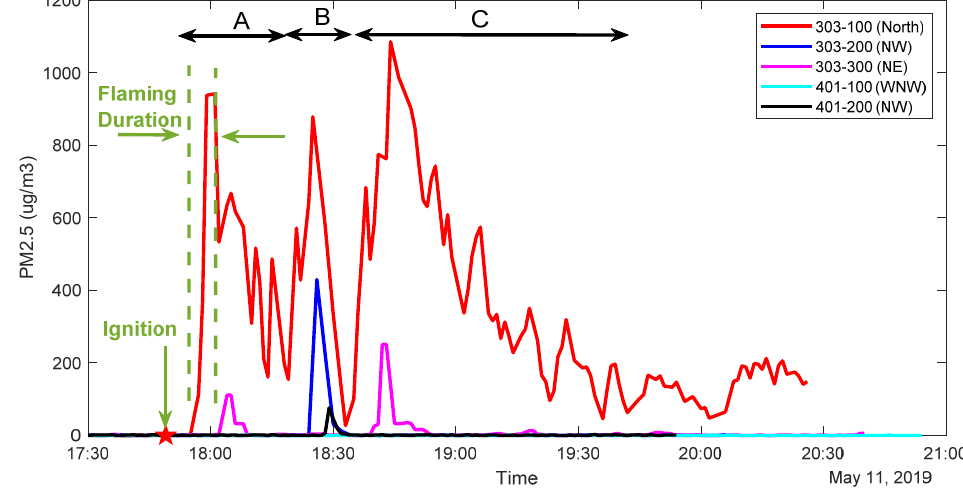
Figure 5. Time series PM 2.5 concentrations at sensor locations downwind of the prescribed fire. Elevated concentrations from flaming and smoldering smokes can be seen during smoke wavefronts A, B, and C, respectively. The symbol in the time axis indicates the time of ignition of